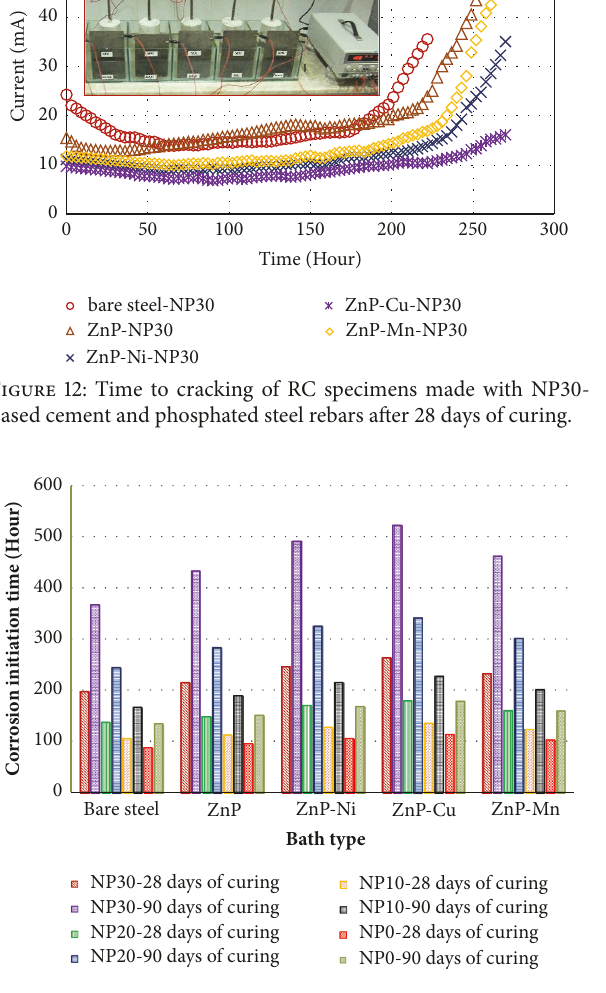
Figure 13: Average corrosion times of RC specimens at 28 and 90 days of curing (straight